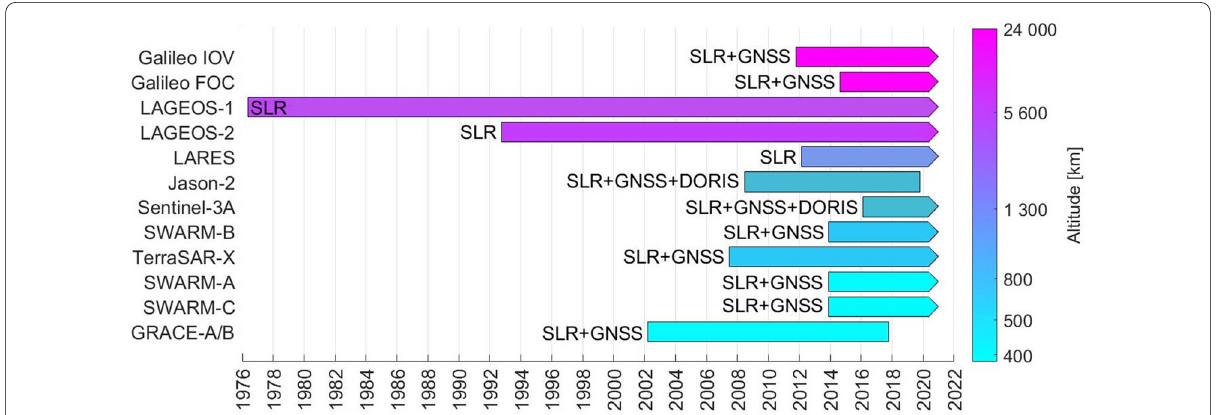
Fig. 1 Satellite missions equipped with various techniques onboard with their operation periods and